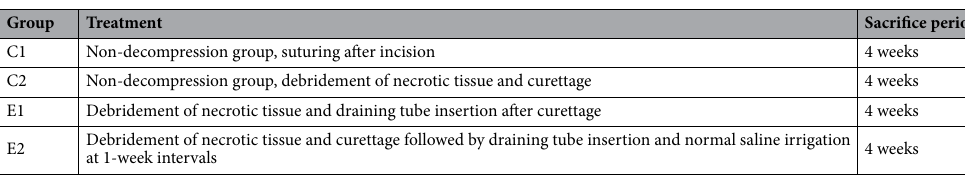
fibrin glue (Greenplast Q; Green Cross, Yongin, Korea) to prevent bacterial leakage (Fig. 1g) 19 . The surgical wound was then carefully sutured at the subcutaneous layer with resorbable 4-0 Vicryl sutures (Polyglactin 910; Johnson & Johnson, Somerville, NJ, US) and the skin closure was performed using 2-0 silk sutures (BLACK SILK 4–0; AILEE, Busan, Korea) (Fig. 1h). Grouping and experimental design. The animals were randomly divided into control (non-decompres- sion groups, C1 and C2) and experimental groups (decompression groups, E1 and E2) (Table 1). The C1 group (n = 3) served as the control group, who only received wound closure. The C2 control group (n = 4) received conventional surgical curettage for jaw OM. The experimental groups were further classified into two subgroups, E1 group (n = 3), which received removal of pus and necrotic bone tissue and curettage, followed by introducing the tube drain and E2 group (n = 4), which received removal of pus and necrotic bone tissue and curettage, drain insertion and irrigation with normal saline every week. Blood samples were collected from the tail vein pre-infection, 1-week post-infection, 2-weeks post-infection/ the start of the treatment, 1-week after treatment, and 4-weeks after the treatment, and rat weights were checked. Surgical treatment was performed under same general anesthesia protocol used in the inoculation procedure that mentioned in the previous section of materials and methods 17 . Two mm inner diameter and three mm outer diameter silicone tubes that were approximately 2 cm in length (Translucent PFA Tubing; DAIHAN Scientific, Wonju, Korea) were used as a drain. The length of the tube was adjusted to each animal according to the post- curettage conditions and these were sutured in place using 4-0 silk sutures. To keep the tubes intact and in place, we used a plastic collar to prevent scratching and accidental displacement of the draining tubes. The animals that died during the experimental trial were recorded for weight loss and clinical symptoms of OM of the jaw. Upon the completion of the six-week experimental trial, the animals were euthanized by CO 2 inhalation. The mandibles of the rats were immediately harvested and carefully isolated.